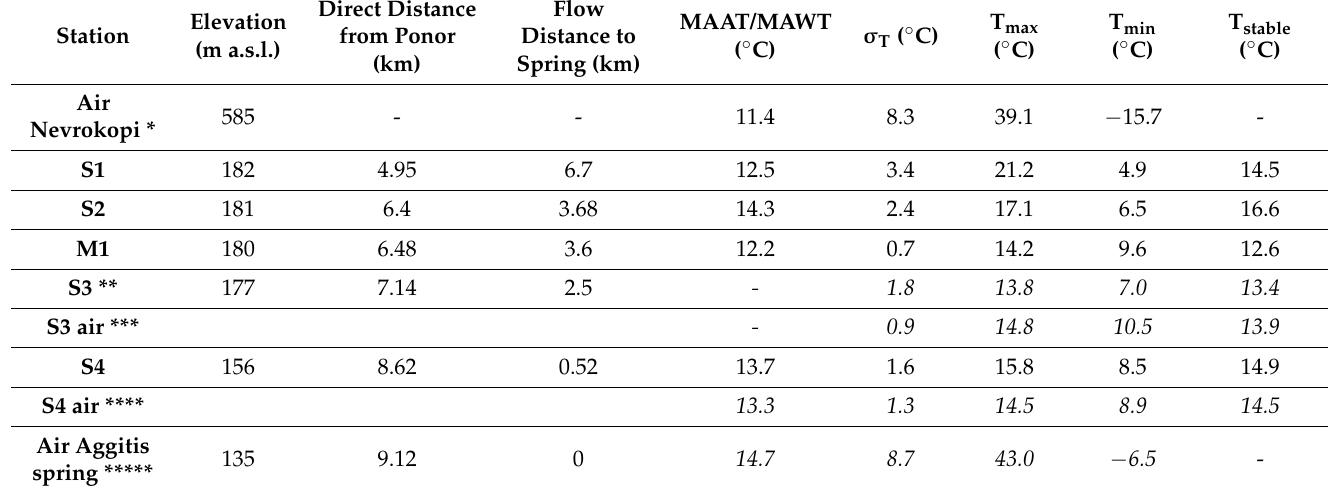
Table 1. List of observation stations with elevation, distance to spring (along flow path), distance to the ponor (direct), and basic statistics for the recorded datasets and the mean annual water temperature (MAWT) and mean annual air temperature (MAAT) from the observation stations for two consecutive hydrological years from 1 September 2020–31 August 2022. Statistics for shorter records are in